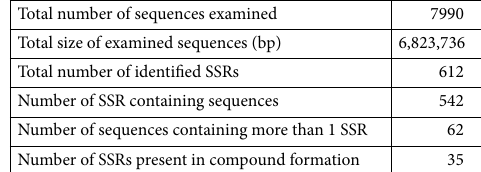
Total number of sequences